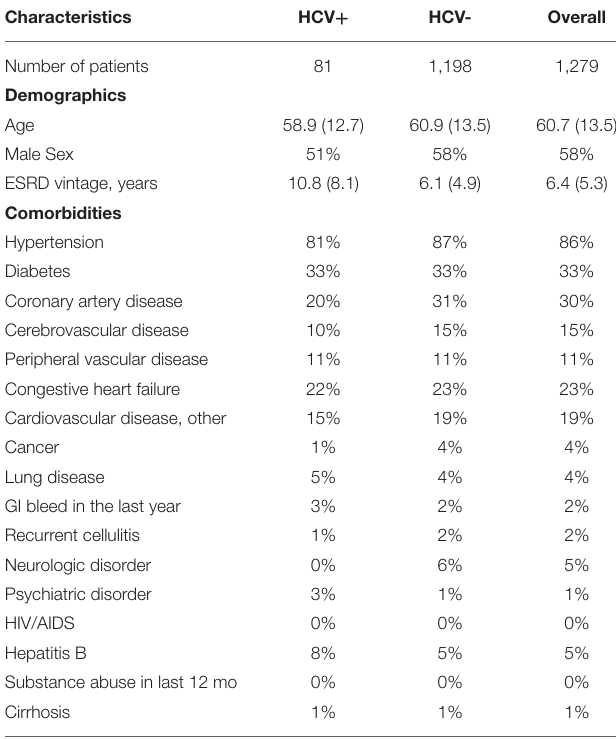
TABLE 1 | Baseline patient characteristics of Chinese HD study patients, by HCV + (China DOPPS, 2019–2021; initial cross-section of patients).